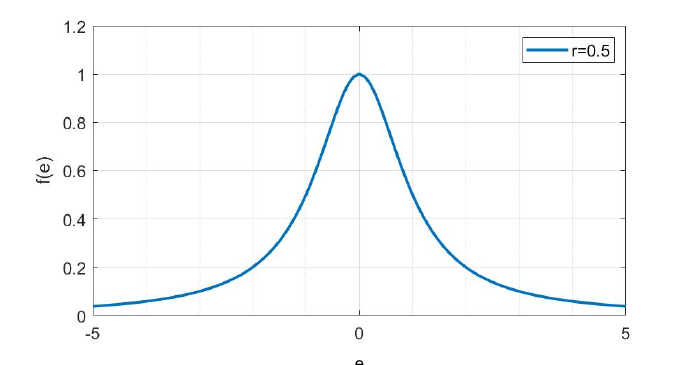
Figure 2. The standard Versoria function ( r =